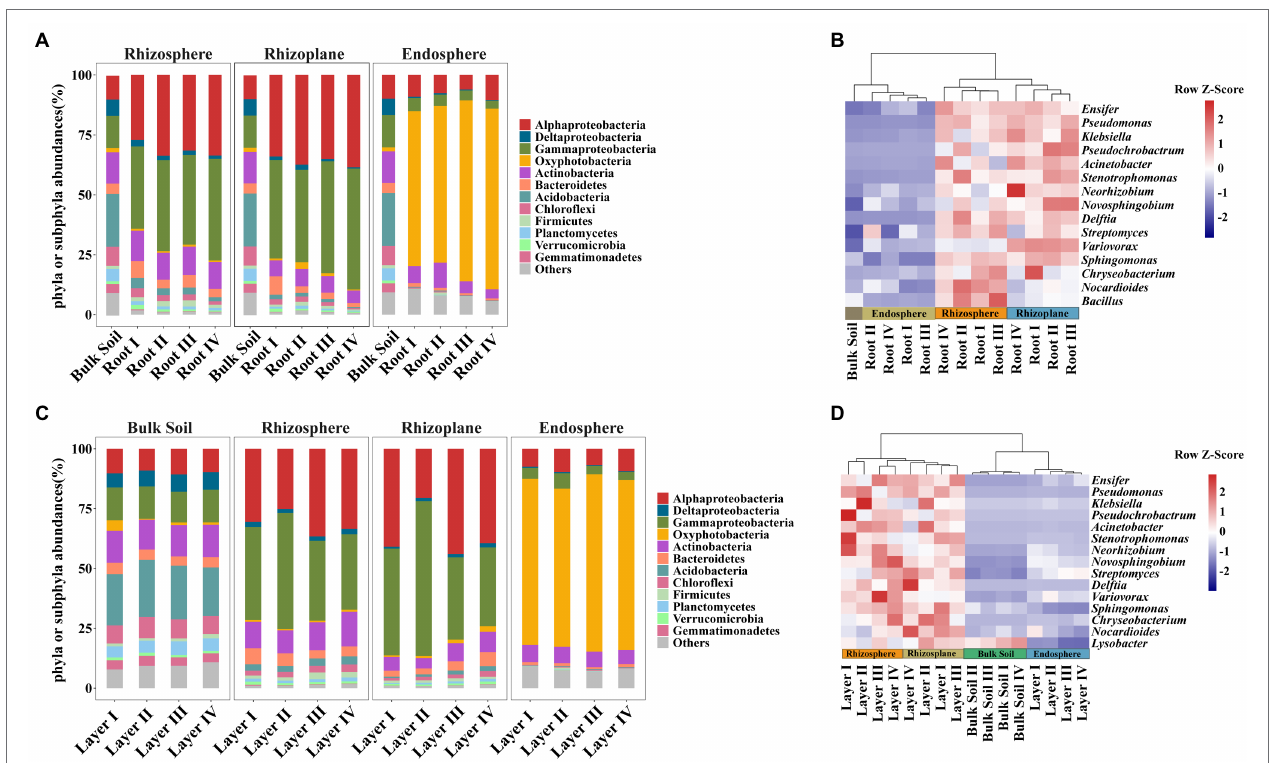
FIGURE 3 | Bacterial community composition plots in different root diameters and rooting depths. (A,C) Bar chart showing the relative abundance of dominant bacterial phyla or subphyla (top 10). (B,D) Heatmap showing the distribution of bacterial genus level (top 15). Heatmap color (blue to dark red) displays the row scaled relative abundance of each taxon across all